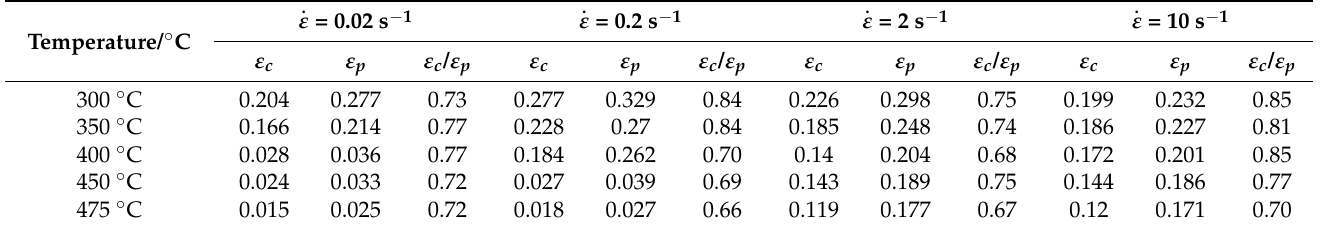
Table 2. Critical strains ( ε c ), peak strain ( ε p ), and their ratio ( ε c / ε p ) at different compression conditions. Temperature/ ◦